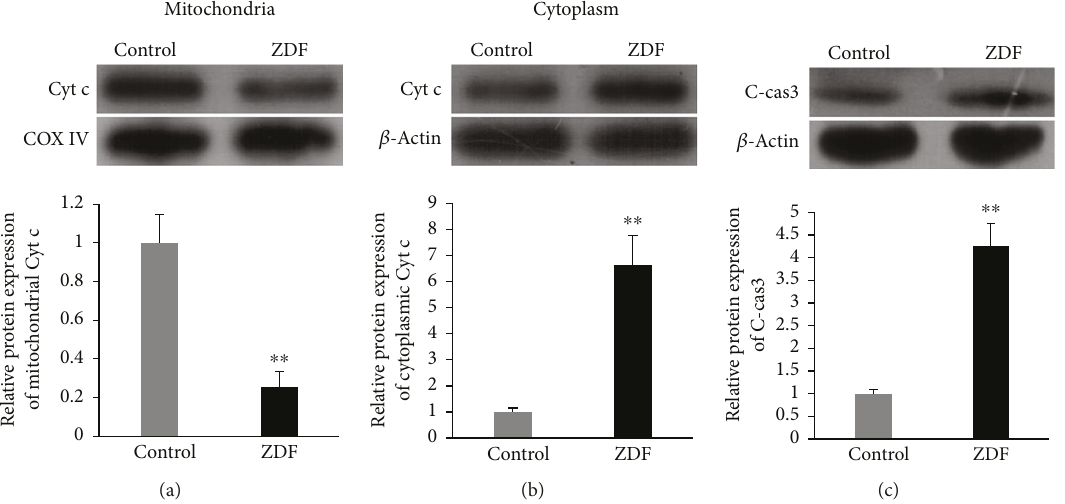
Figure 6: Mitochondria-dependent apoptosis in the auditory cortex of rats in the ZDF and control groups. (a) Protein expression of mitochondrial Cyt c in the auditory cortex of rats in the ZDF and control groups. (b) Protein expression of cytoplasmic Cyt c in the auditory cortex of rats in the ZDF and control groups. (c) Protein expression of C-cas3 in the auditory cortex of rats in the ZDF and control groups. Data are expressed as mean ± SD ( n = 4 ). ∗∗ P < 0 01 .